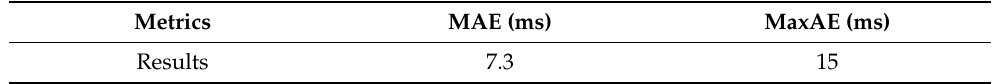
Table 2. The estimation accuracy of T v − T h